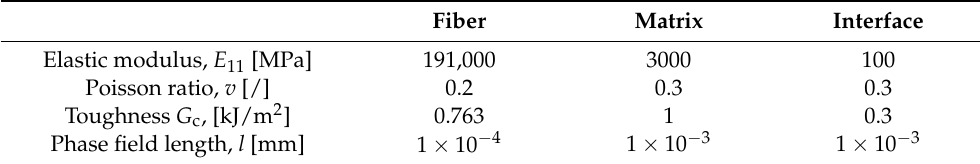
Table 1. Constituents’ mechanical